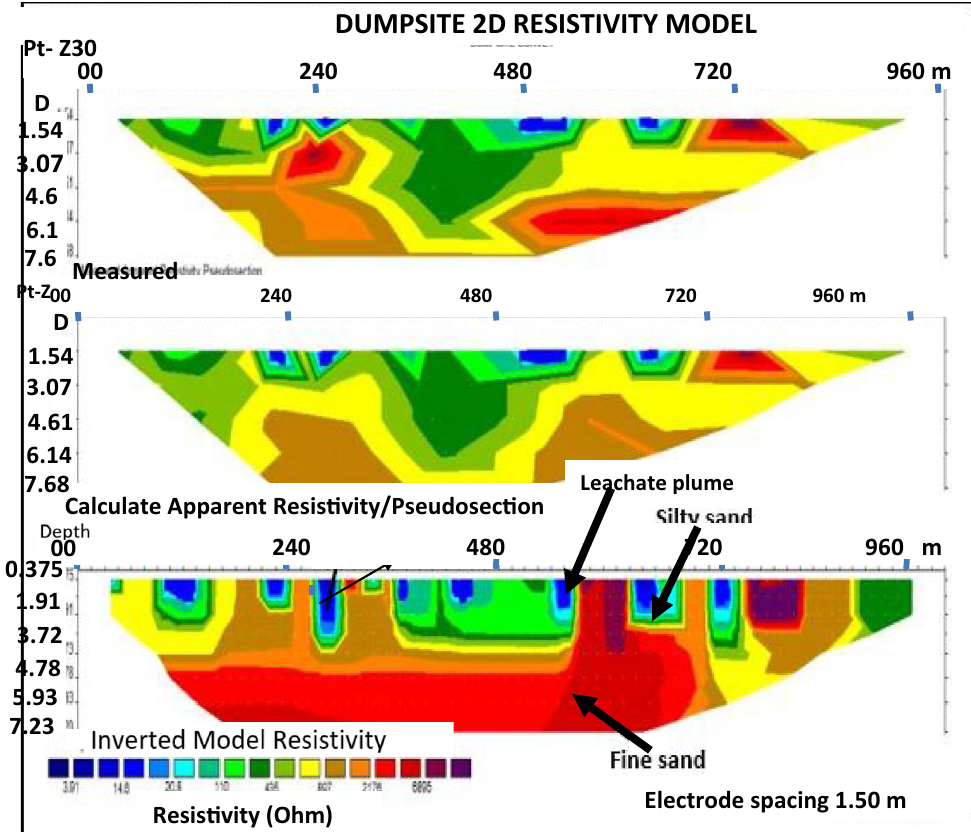
Figure 6. 2D inversion of the Wenner-array data along profile 2 showing variation in resistivity in the subsurface, with blue colour representing least resistivity and red colour shoing highest resistivity